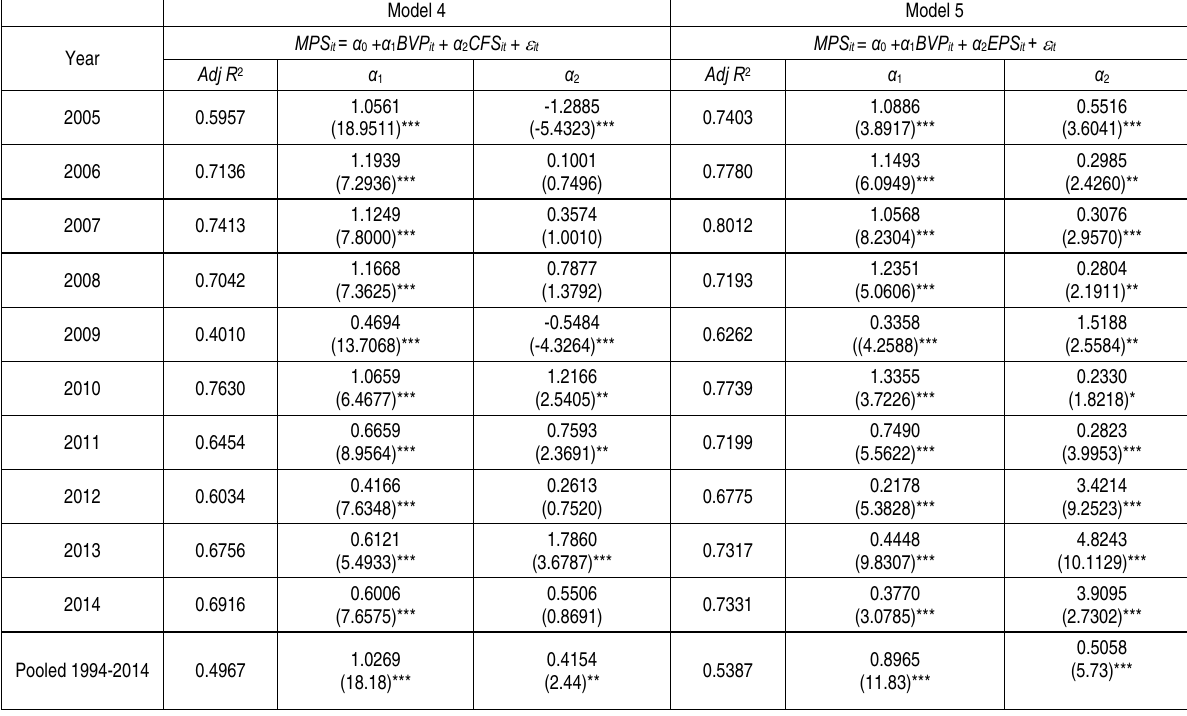
Table 5 (cont.). Analyses of the value relevance of combined book value and earnings and combined book value and cash flow: multiple linear regression